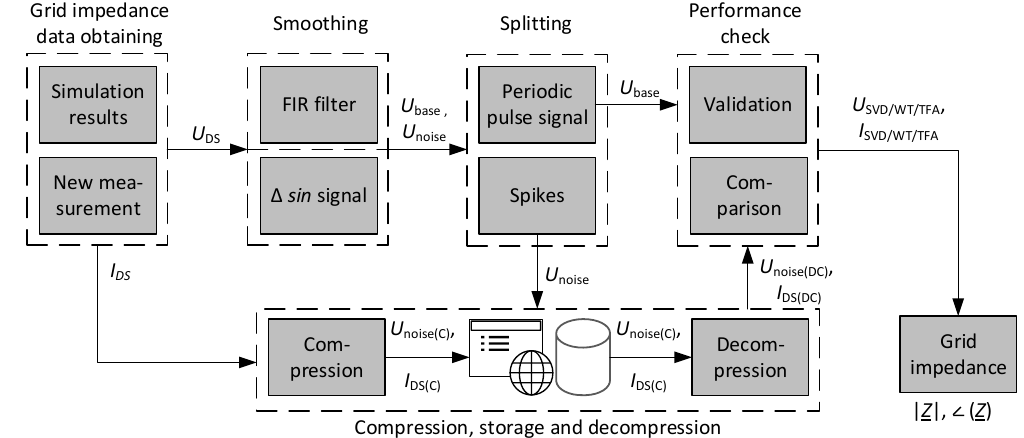
Figure 7. Flowchart of the novel paper